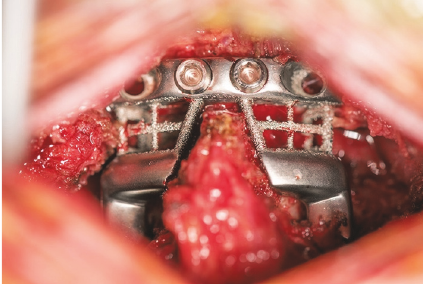
Figure 7: Intraoperative implantation of 3DP custom printed spinal prosthesis for a posterior C1-C2 fusion (source: reproduced and adapted with permission from Phan et